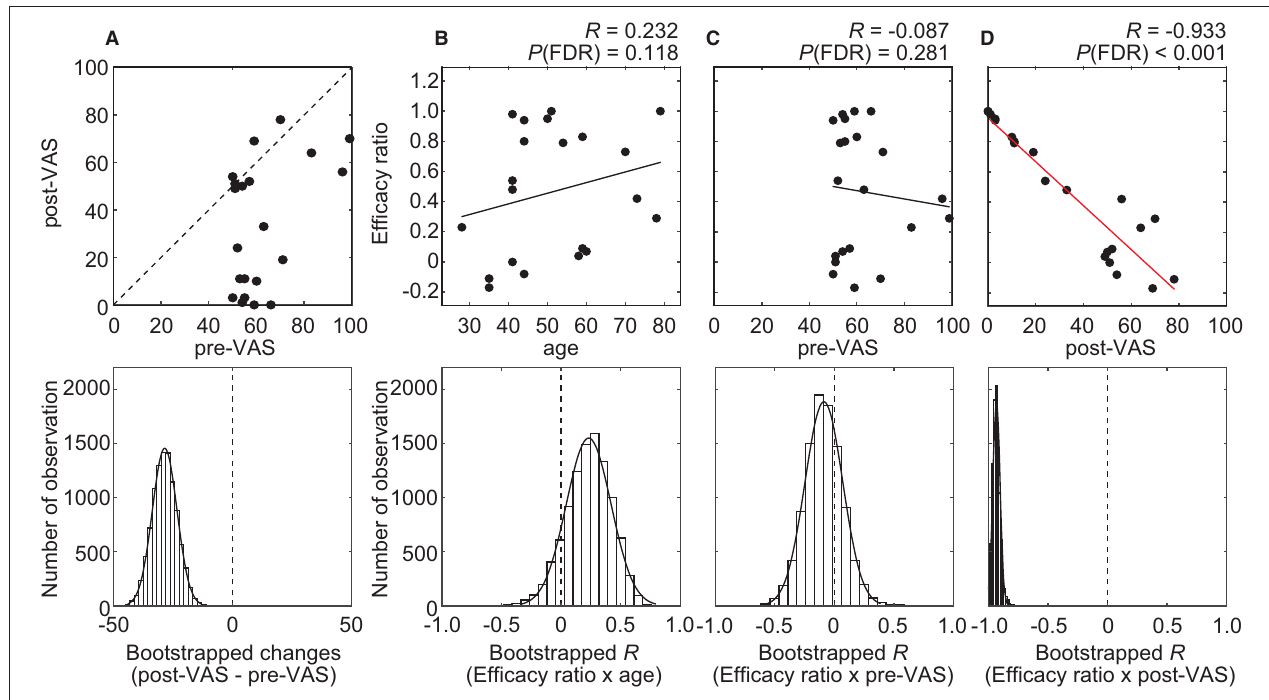
FIGURE 3 | Results of the statistical analysis on behavioral data. (A) A scatterplot (top row) visualizes the relationship between pre- and post-VAS. The histogram (bottom row) shows the distribution of bootstrap statistics (i.e., average differences between pre- and post-VAS computed with resampled dataset) across 10,000 iterations. (B–D) Scatterplots (top row) and regression lines visualize the relationship between the efficacy ratio and age (B) , pre-VAS (C) , or post-VAS (D) . A red regression line indicates significant correlation. The histogram (bottom row) shows the distribution of bootstrap statistics [i.e., Pearson’s correlation coefficient (R) between the efficacy ratio and age (B) , pre-VAS (C) , or post-VAS (D) computed with resampled dataset] across 10,000 iterations.